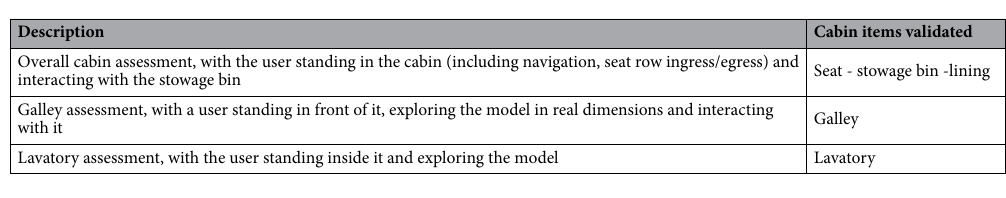
Table 2. Test case definition and connection with cabin